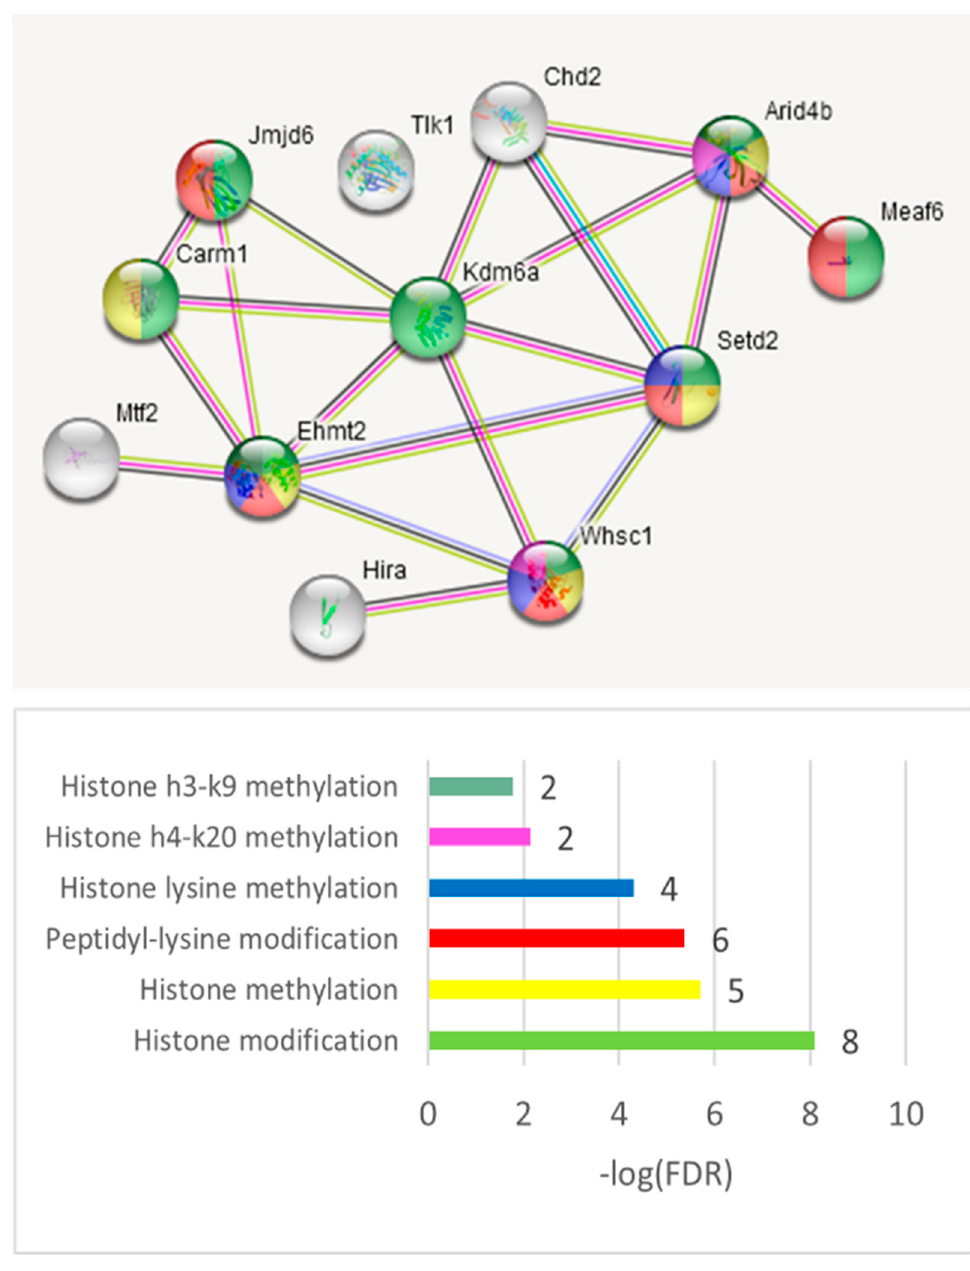
Figure 20. The 11 ES abundant closely connected genes with NMD exons from Table S7c (string- db.org; KW-0156: ‘Chromatin regulator’; 12 genes). db.org; KW-0156: ‘Chromatin regulator’; 12